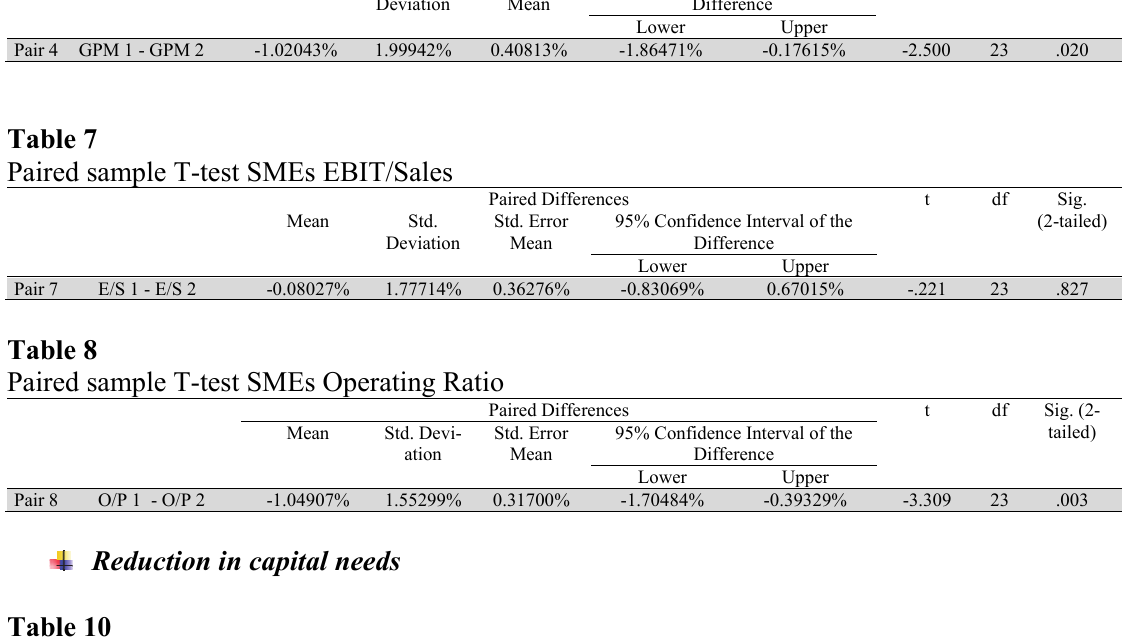
Paired sample T-test SMEs Debt-to-Equity